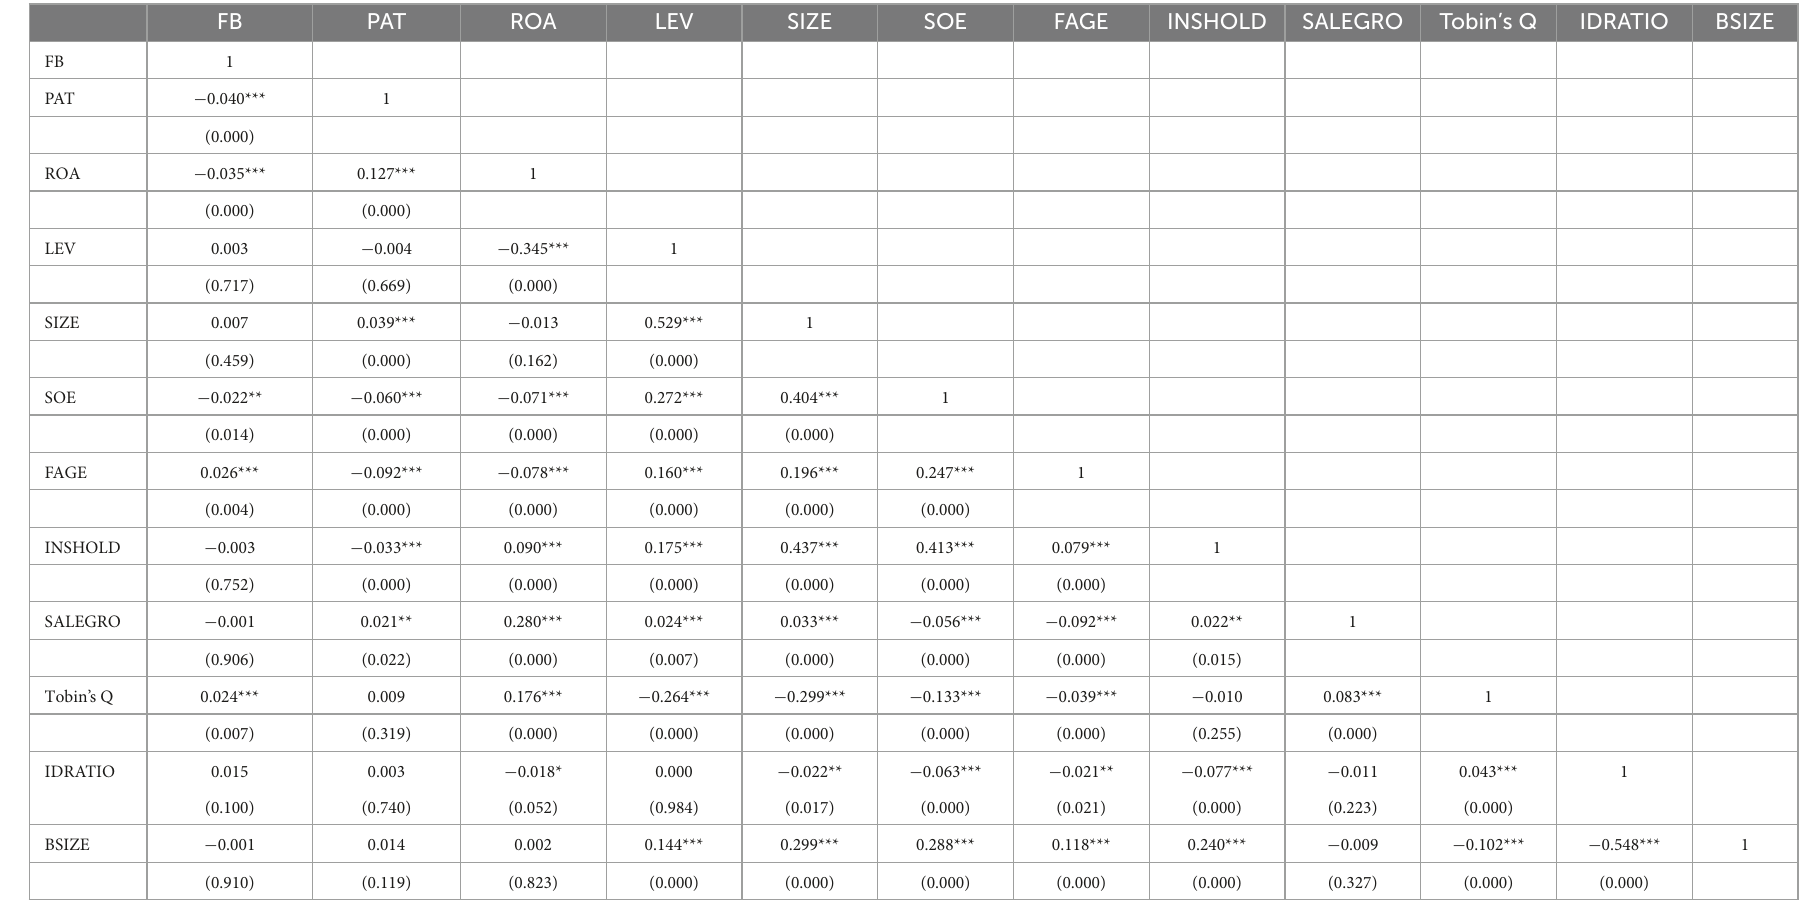
TABLE 3 Pearson correlation